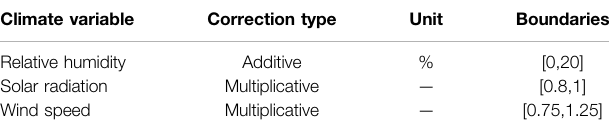
TABLE 3 | Calibration range for relative humidity, solar radiation and wind speed transfer functions. Climate variable